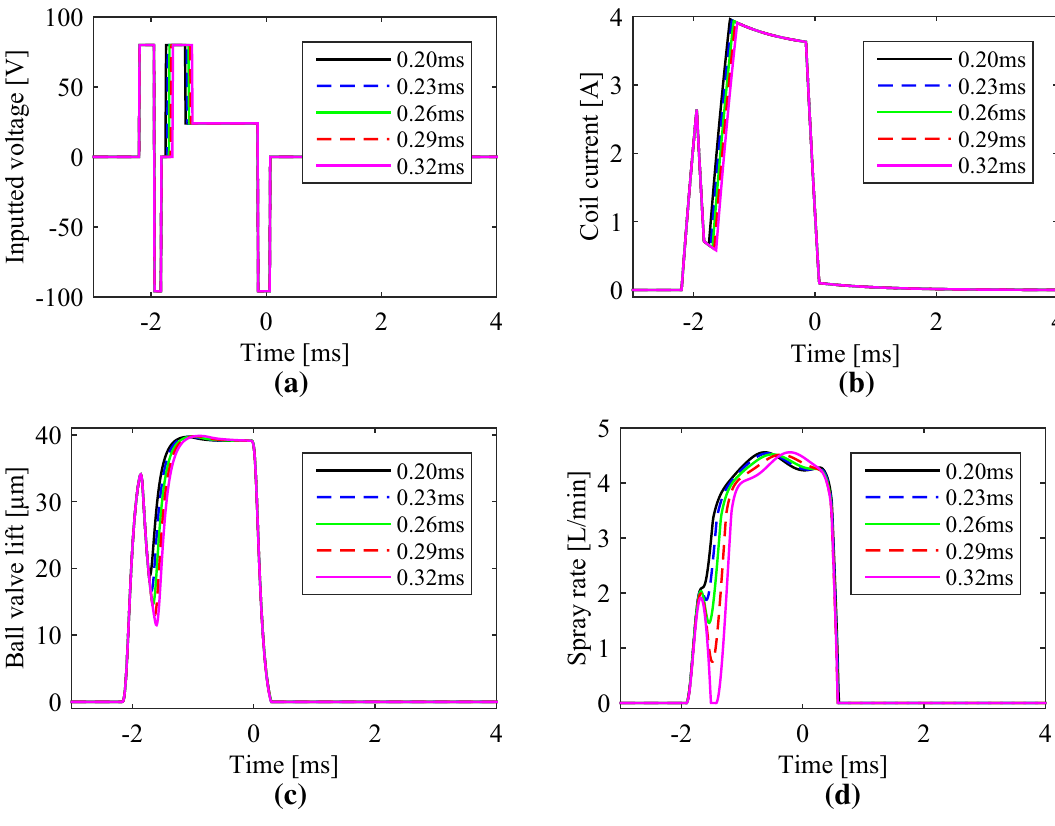
Figure 8. Boot shape injections with different dwell time from 0.20 ms to 0.32 ms: ( a ) driving voltage; ( b ) coil current; ( c ) ball valve lift; ( d ) spray